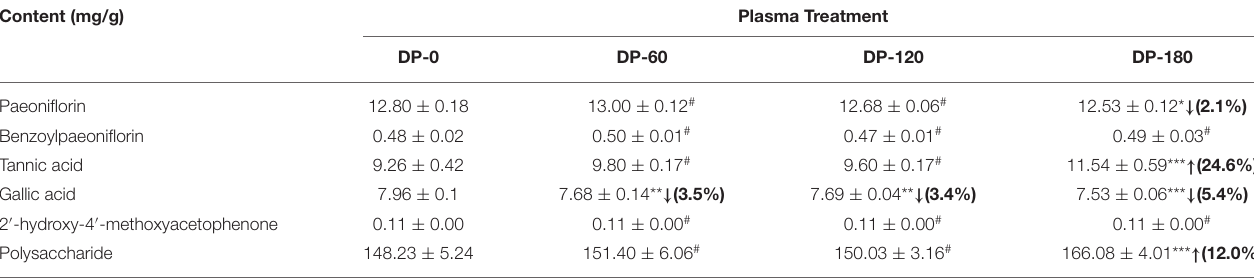
TABLE 1 | Six bioactive compound contents in the extraction of RPA: DP-0, DP-60, DP-120, and DP-180 groups. Content